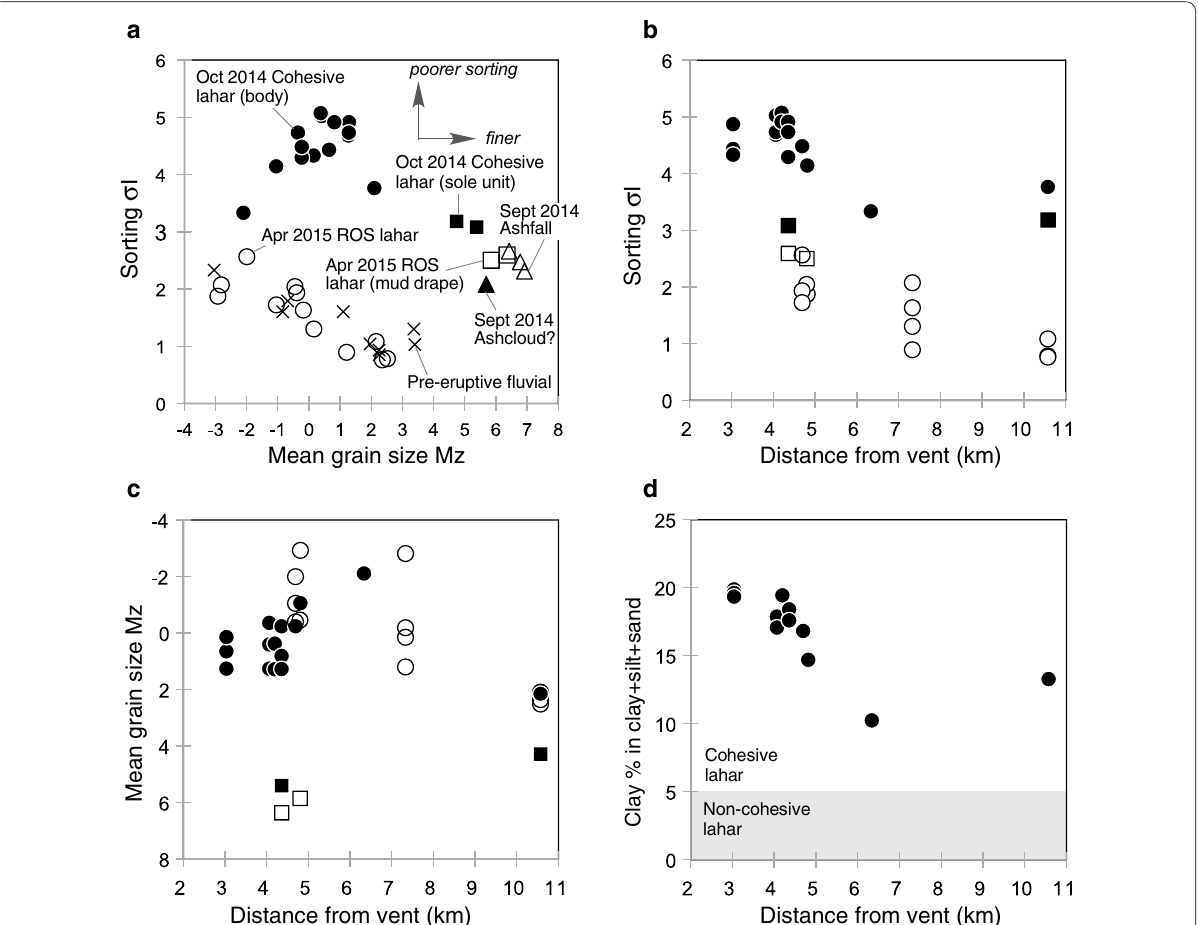
Fig. 7 Grainsize characteristics of pre-eruptive, 2014 eruptive and post-eruptive lahar deposits in the Akagawa and Nigorigawa Rivers and around Ontake Volcano. a Sorting and mean grainsize of samples. b Sorting and c mean grainsize versus distance from the Jigokudani vents for samples of October 2014 rain-triggered and April 2015 ROS-triggered lahar deposits. Note that the samples from debris flow deposits represent grainsize less than cobble because of limitation of sampling of larger clasts at the field. d Percentage of clay in clay